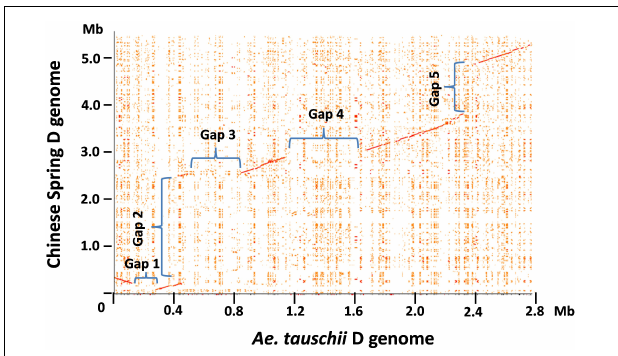
FIGURE 1 | Pairwise comparison of the hexaploid and Ae. tauschii D genome regions harboring prolamin and resistance gene families. The dot plot between the orthologous regions from the hexaploid wheat Chinese Spring and diploid Ae. tauschii was performed using the r2cat program with default parameter setting (Husemann and Stoye, 2010). Each distinct gap on the dot plot is assigned a number, and the sequences involved in the gap regions are described in the